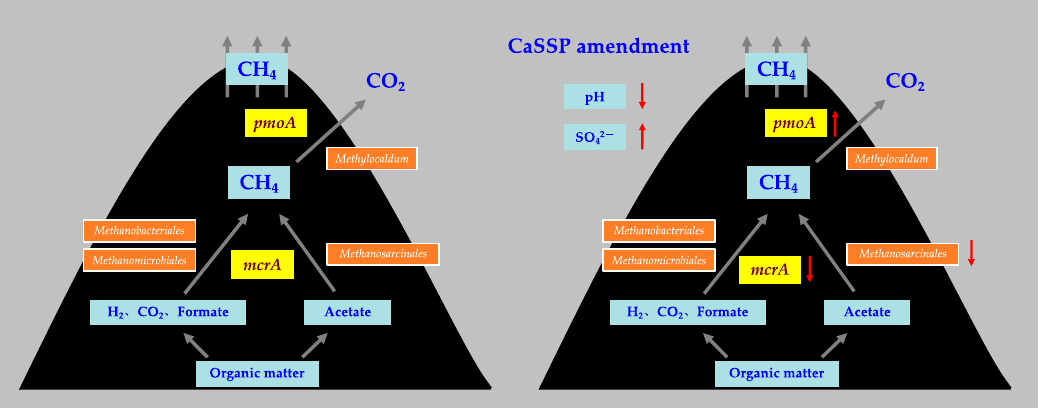
Figure 7. A conceptual diagram illustrating the effects of adding superphosphate on manure properties as well as methane fluxes.